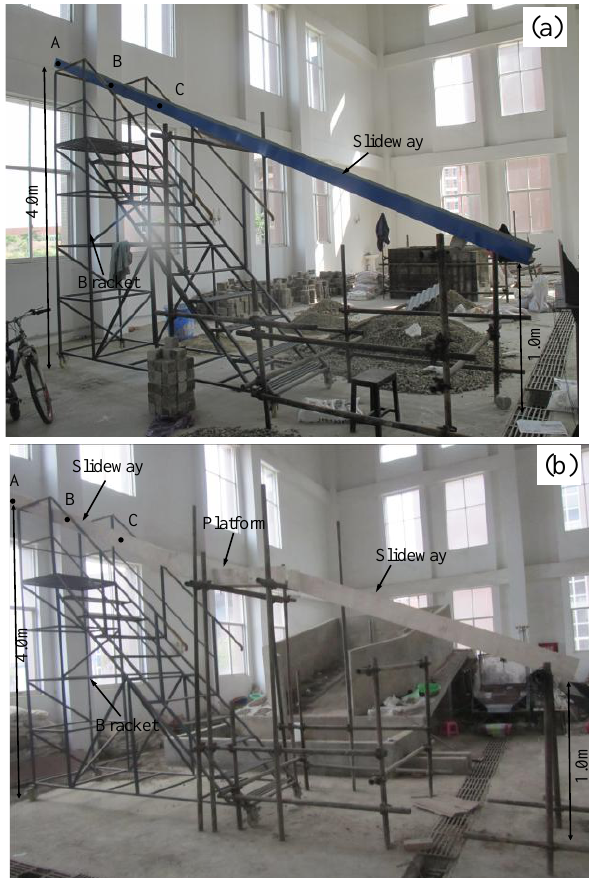
Figure 1. The rockfall devices: (a) slideway without platform and (b) slideway with a platform.